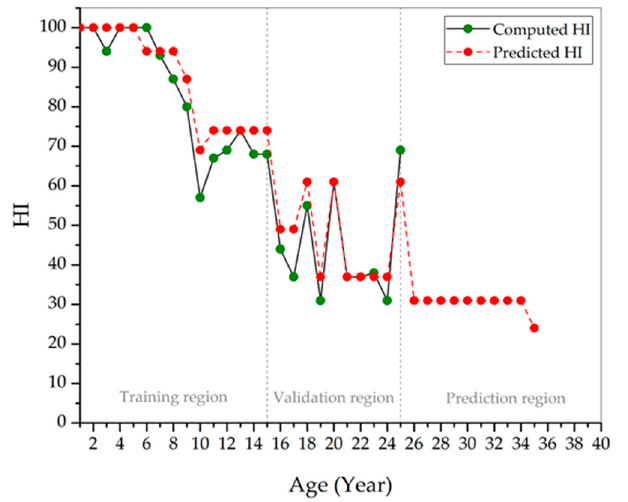
Figure 8. Comparison between computed and predicted health index.